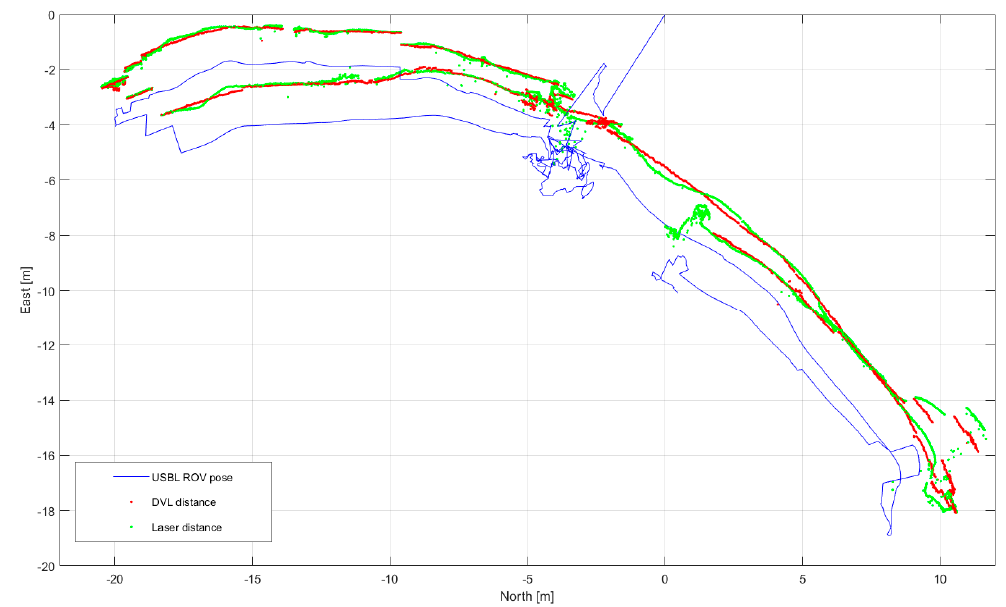
Figure 12. The position of the ROV is the blue line, the red dots are DVL distance measurements, and the green dots are laser measurements.